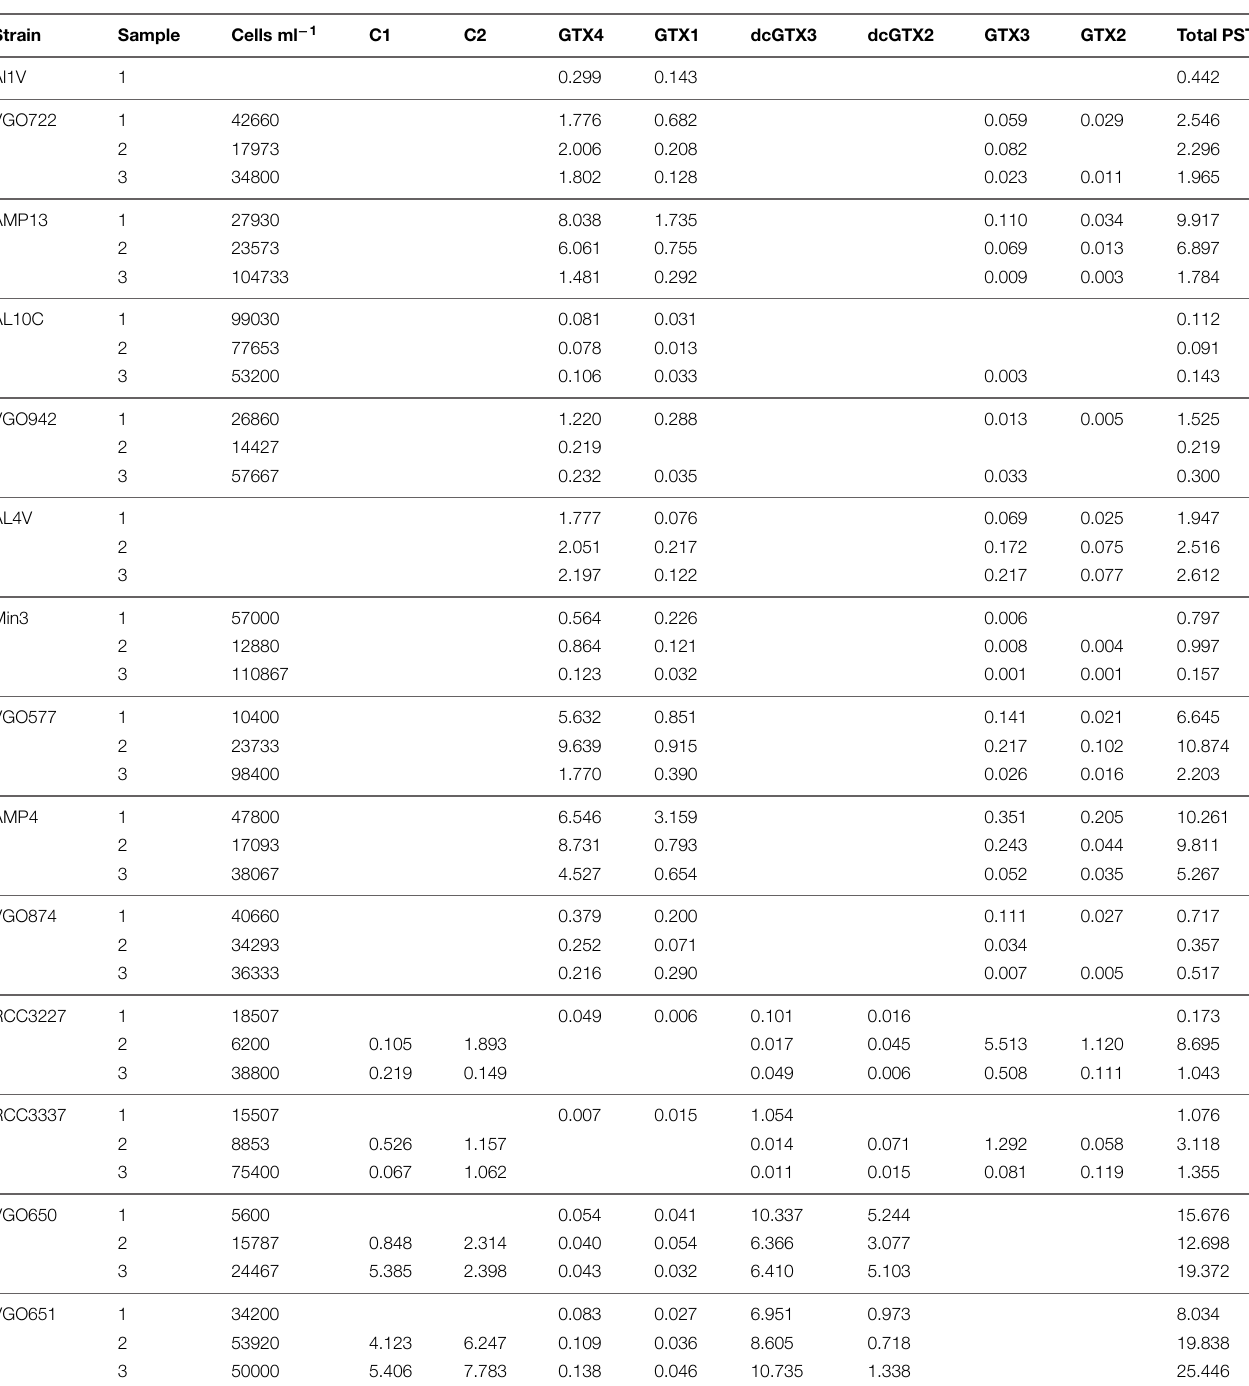
TABLE 3 | PST measurements in fmol cell − 1